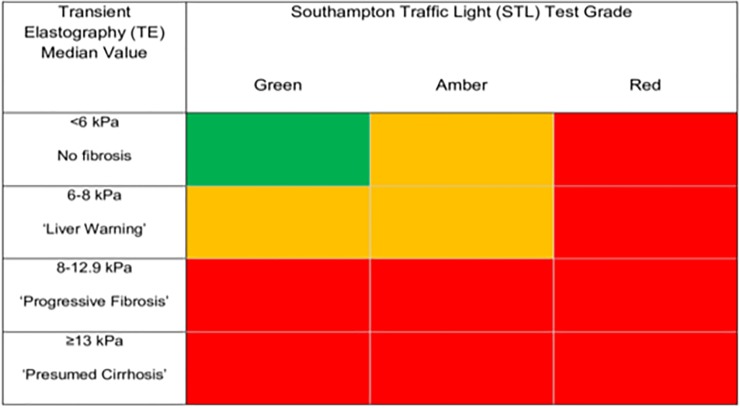
Green = no fibrosis, amber = ‘liver warning’, red = progressive fibrosis or cirrhosis.